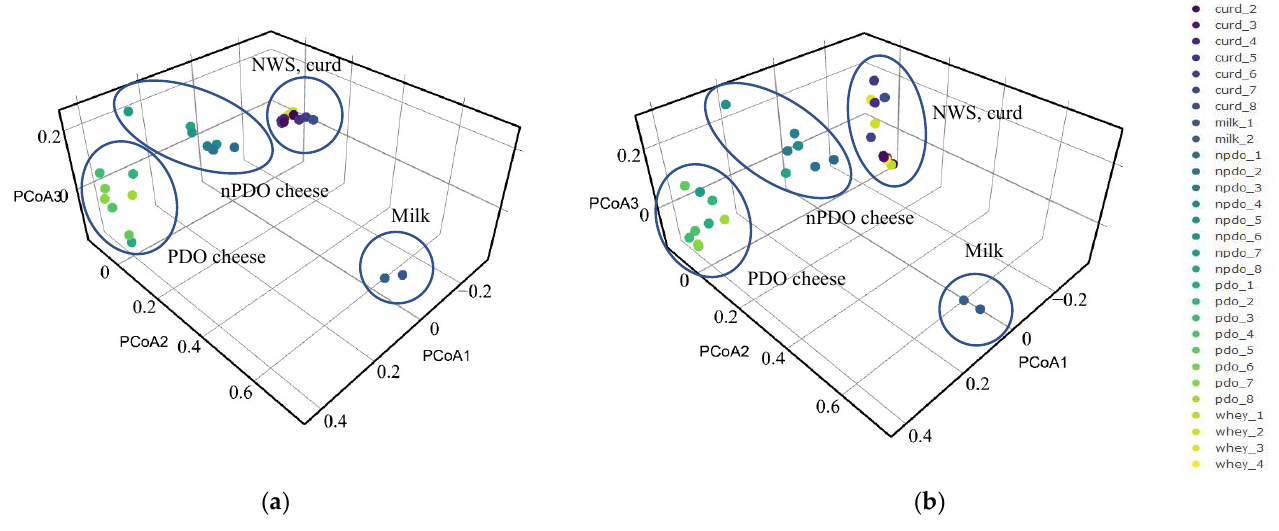
Figure 2. Principal coordinate analysis (PCoA) based on the Bray–Curtis distance matrix of operational taxonomic units (OTUs) identified at the family ( a ) and genus ( b ) level of milk, NWS (whey), and cheese samples (PDO and nPDO cheeses). The ellipses were drawn by hand to help visualizing the different sample